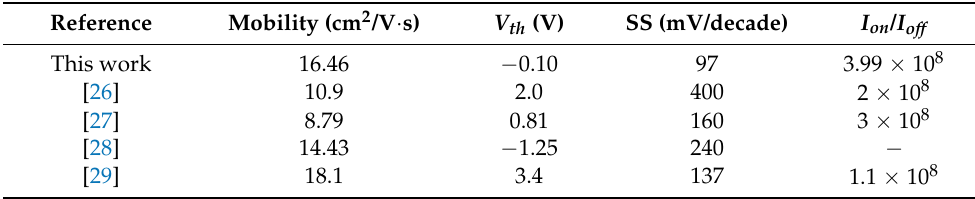
Table 2. Performance metrics of InGaZnO TFT in this work and other reported SiN x -related InGaZnO